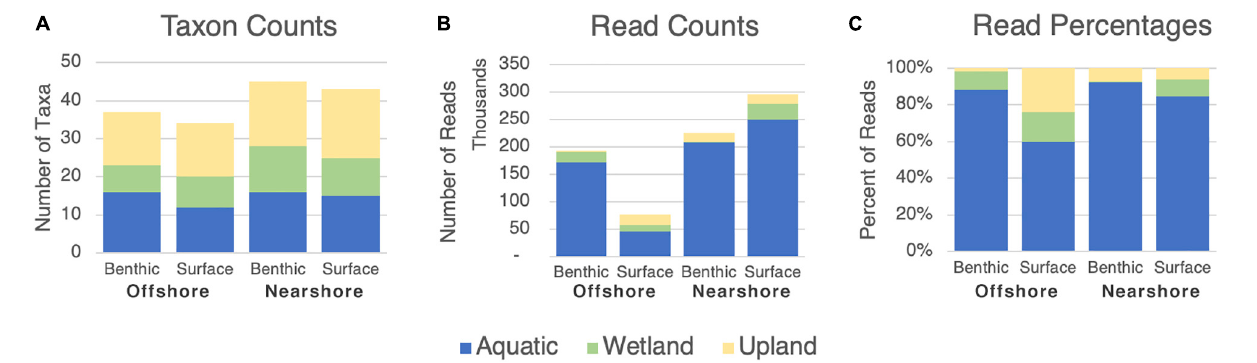
FIGURE 5 | Prevalence of wetland designations among vascular plant taxa categories identified by eDNA sampling in four spatial compartments. “Aquatic,” “Wetland,” and “Upland” correspond to the three aggregated statuses in Table 2B above. Category labels are the four spatial sampling compartments (depth/distance combinations). (A) Numbers of taxa from each broad category represented in eDNA results. (B) Numbers of reads represented in eDNA results. (C) Percentage of reads represented in eDNA results.